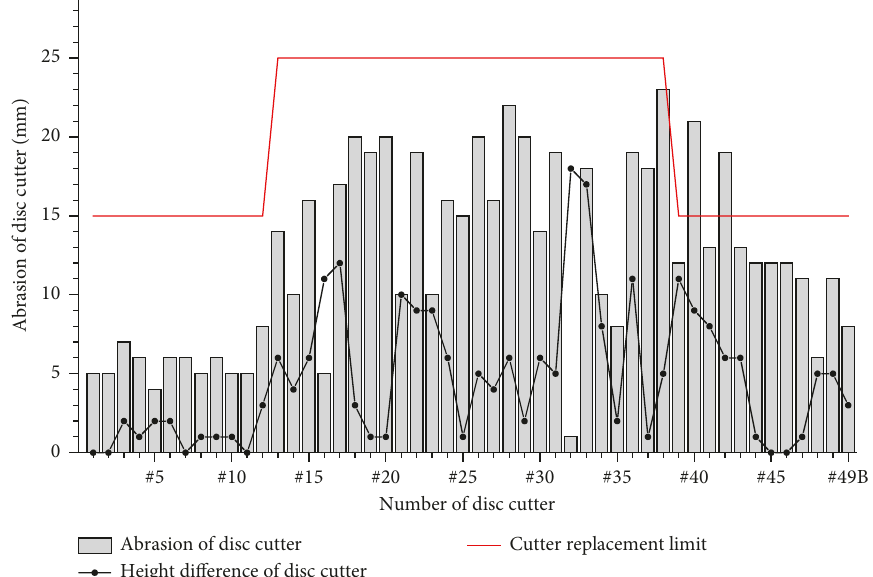
Figure 5: Measurement results of the disc cutter